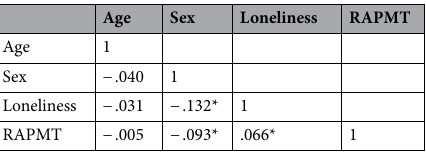
Table 2. Pearson’s correlation among descriptive statistics. * p < .05; RAPMT: Raven’s advanced progressive matrices test.